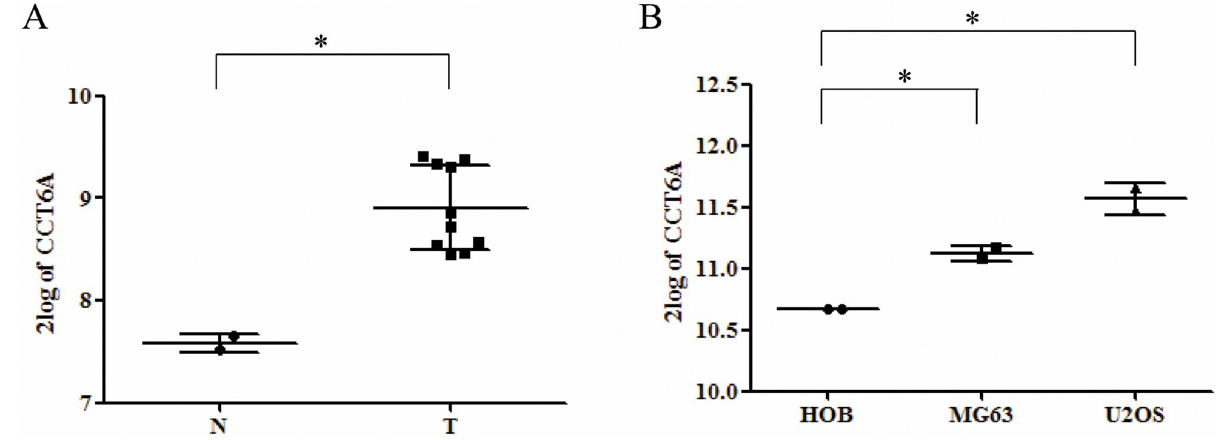
Fig 1. Expression levels of CCT6A in osteosarcoma tissue and cells. The R2 genomic analysis and visualization platform were used to analyze the mRNA expression of the protein-coding gene chaperonin-containing TCP1 subunit 6A (CCT6A) in osteosarcoma tissue and cells � p < 0.05. mRNA, messenger ribonucleic acid; N, normal tissue; T, cancer